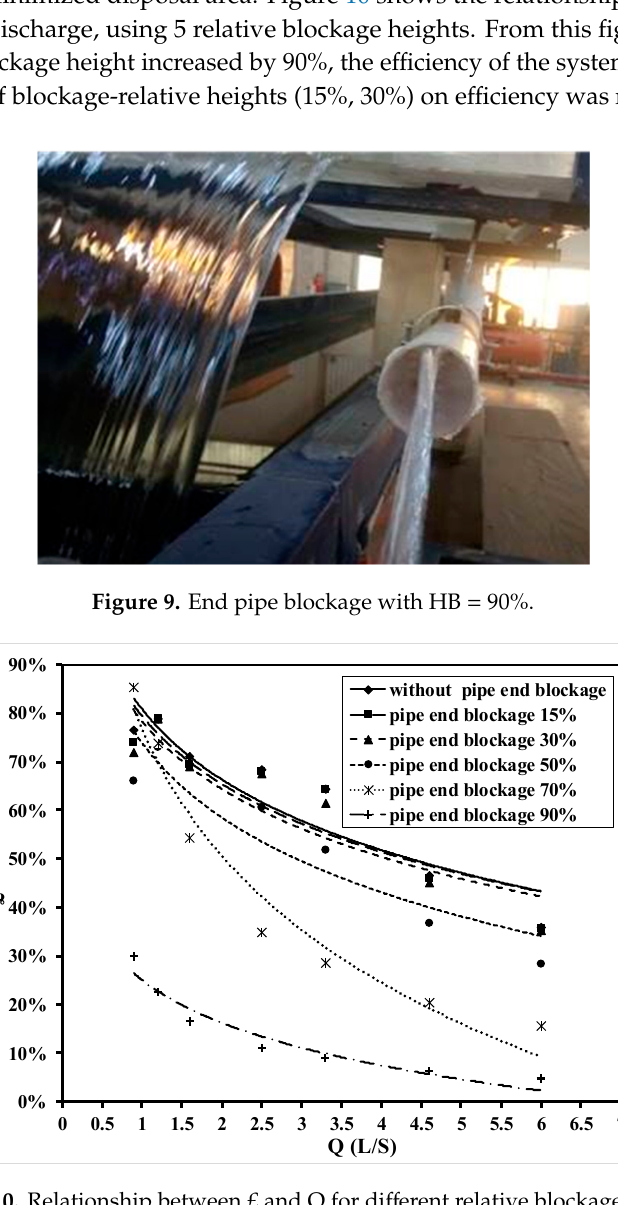
Figure 10. Relationship between £ and Q for different relative blockage heights.